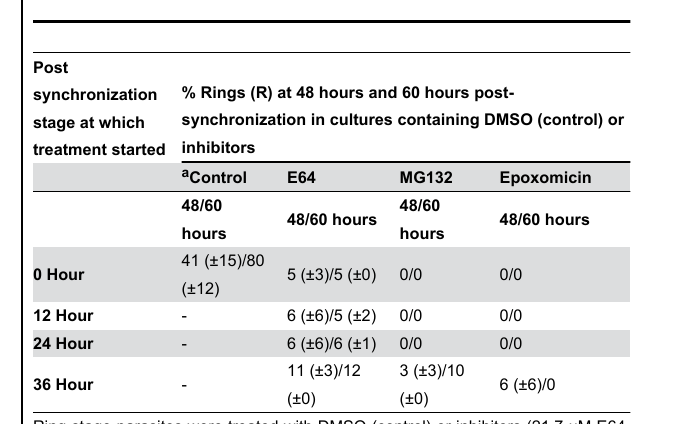
% Rings (R) at 48 hours and 60 hours post- synchronization in cultures containing DMSO (control) or